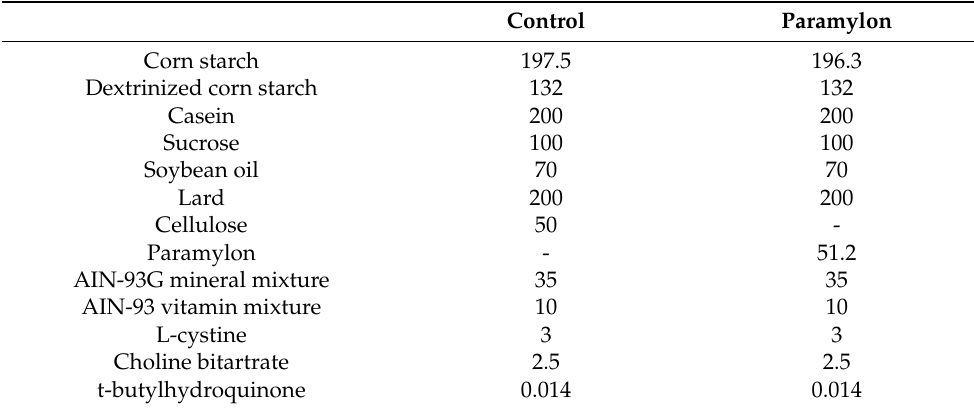
Table 1. Test diet compositions